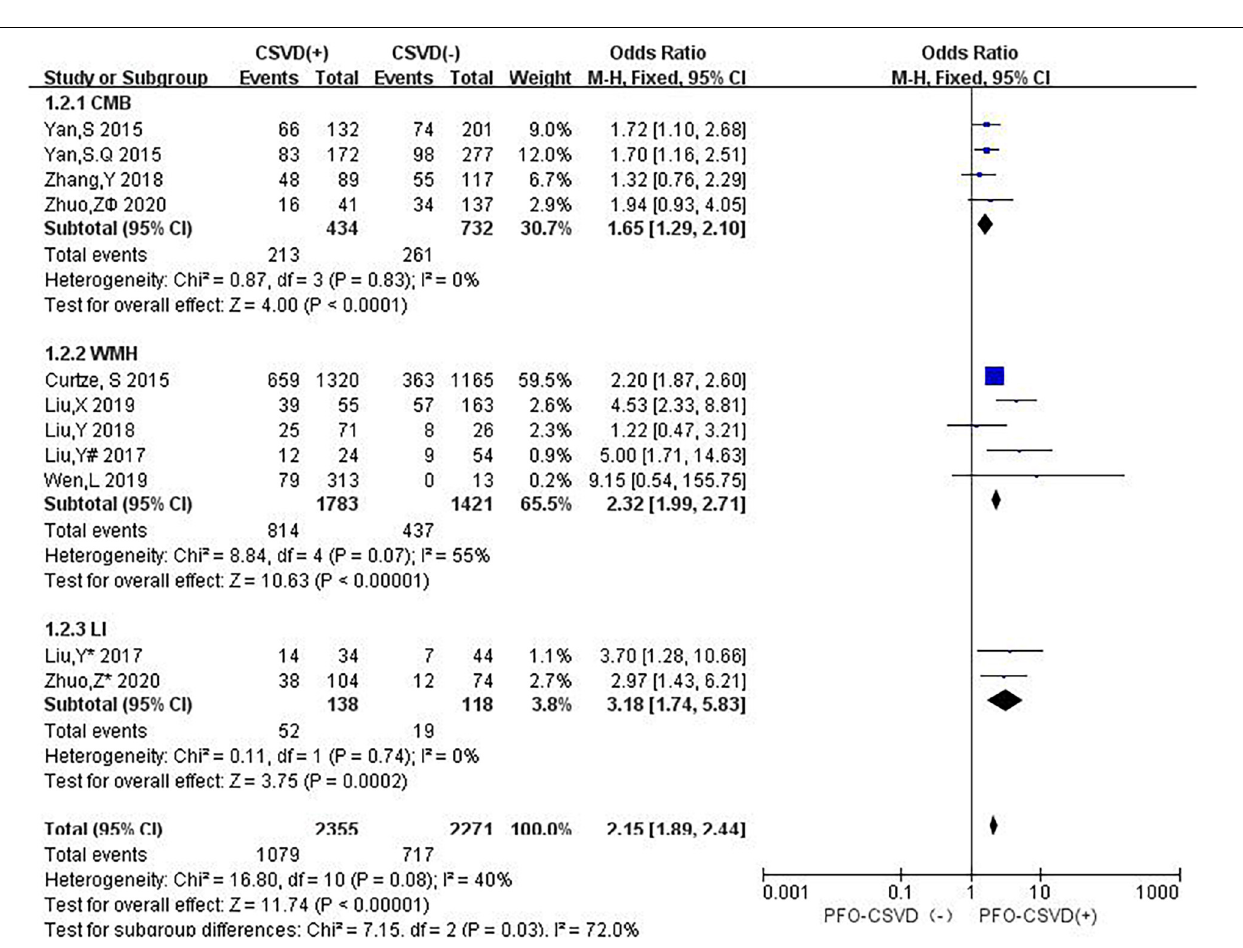
FIGURE 9 | Forest plot of subgroup analysis showing the impact of subtypes of CSVD on 3-month PFO.